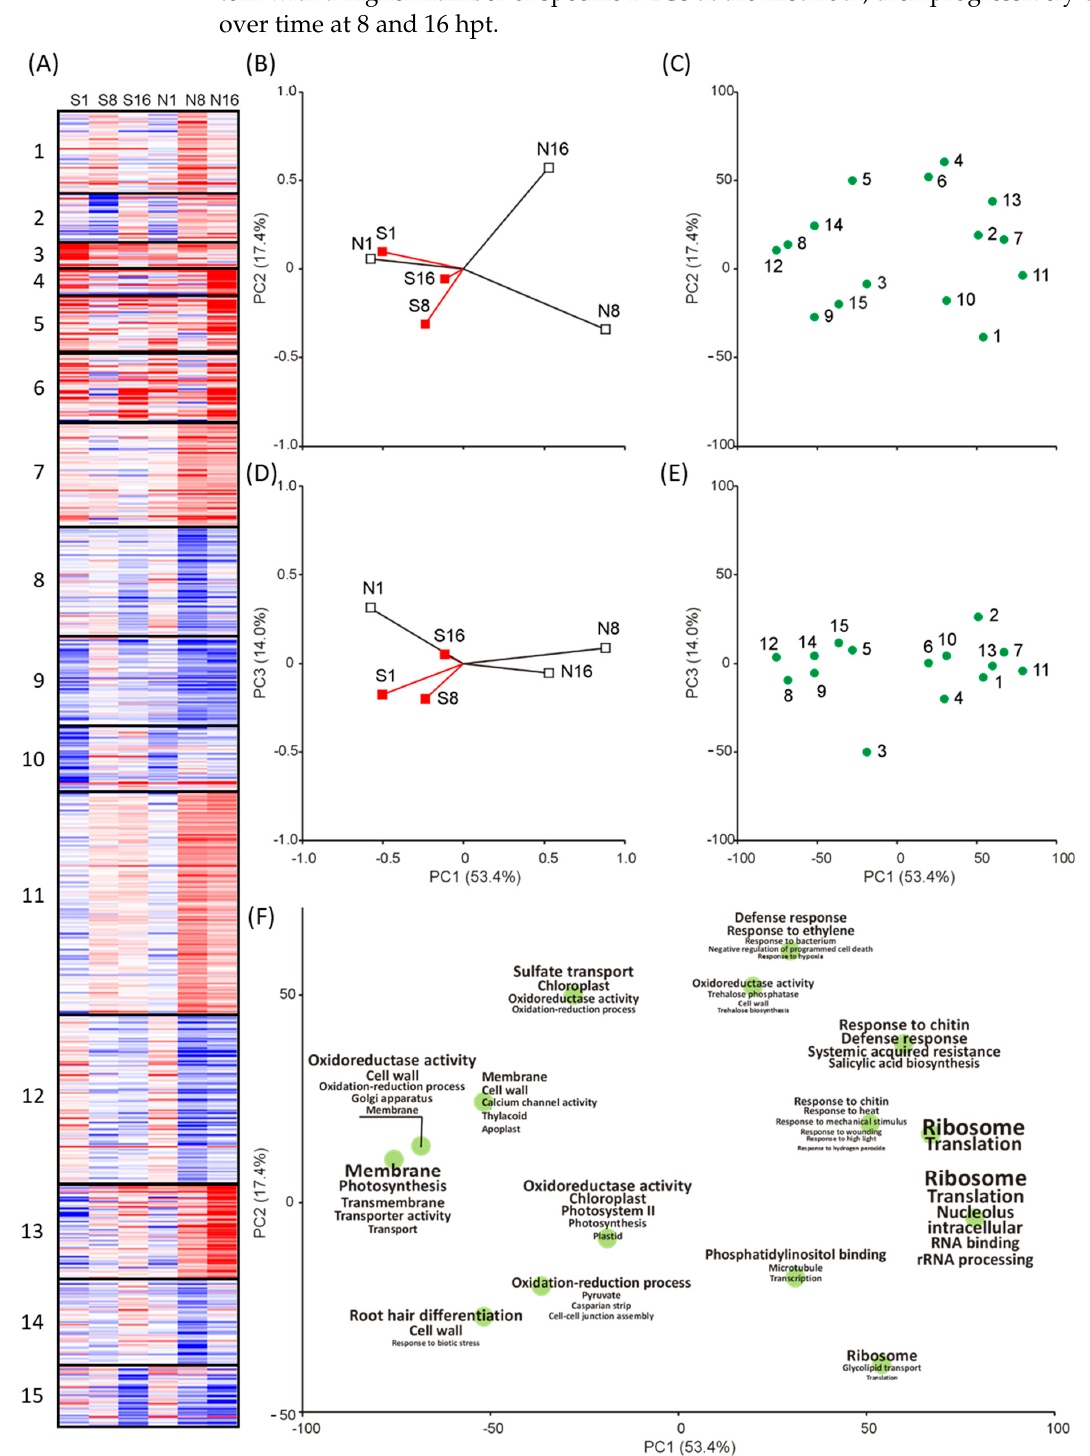
Figure 3. Classification and ordination of gene transcripts and samples based on RNA-seq data. Panels refer to heat map and K-means clustering based on fold changes in all stages of genes resulting differentially expressed (DEGs) in at least one of the six treatments (2 DNA sources × 3 observation times) ( A ). From red (high) to blue (low) the level of fold change values is shown. PCA ordination, with loading vectors of the samples ( B , D ) labelled by treatment (S: self-DNA, N: nonself-DNA) and time (1, 8, and 16 h), or factorial scores of cluster centroids ( C , E ) is shown. In ( F ), word cloud plot showing the position of each cluster in the first and second principal component space (as in ( C )), overlapped by the keywords more frequently occurring in enriched gene ontologies (font size inversely log-proportional to enrichment p-value).